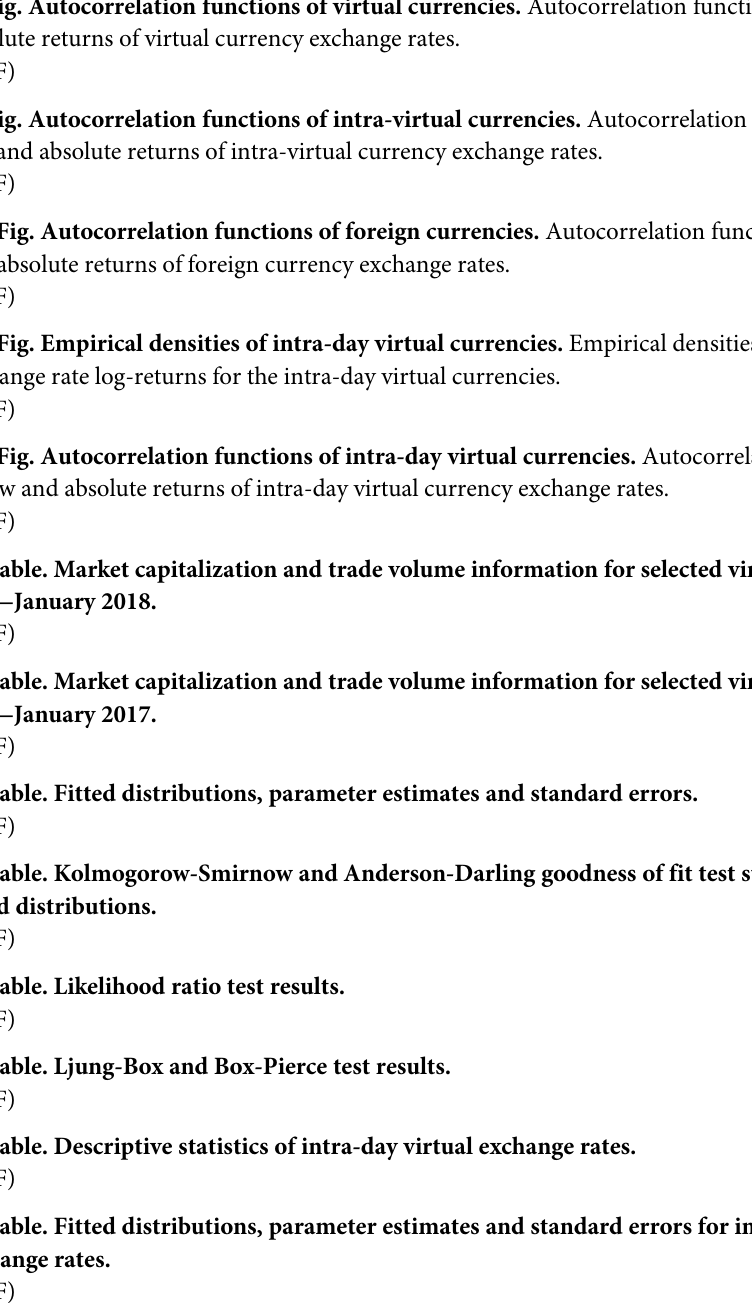
S6 Fig. Volatility clustering in foreign currency log-returns. Volatility clustering in log- returns of foreign currency exchange rate group. (PDF) S7 Fig. Shape parameter κ of Subbotin distribution. Shape parameter κ of Subbotin distribu- tion for virtual, intra-virtual and foreign currency exchange rate log-returns (daily). (PDF) S8 Fig. Autocorrelation functions of virtual currencies. Autocorrelation function of raw and absolute returns of virtual currency exchange rates. (PDF) S9 Fig. Autocorrelation functions of intra-virtual currencies. Autocorrelation function of raw and absolute returns of intra-virtual currency exchange rates. (PDF) S10 Fig. Autocorrelation functions of foreign currencies. Autocorrelation function of raw and absolute returns of foreign currency exchange rates. (PDF) S11 Fig. Empirical densities of intra-day virtual currencies. Empirical densities of currency exchange rate log-returns for the intra-day virtual currencies. (PDF) S12 Fig. Autocorrelation functions of intra-day virtual currencies. Autocorrelation function of raw and absolute returns of intra-day virtual currency exchange rates. (PDF) S1 Table. Market capitalization and trade volume information for selected virtual curren- cies—January 2018. (PDF) S2 Table. Market capitalization and trade volume information for selected virtual curren- cies—January 2017. S3 Table. Fitted distributions, parameter estimates and standard errors. (PDF) S4 Table. Kolmogorow-Smirnow and Anderson-Darling goodness of fit test statistics for fitted distributions. S5 Table. Likelihood ratio test results. S6 Table. Ljung-Box and Box-Pierce test results. S7 Table. Descriptive statistics of intra-day virtual exchange rates. (PDF) S8 Table. Fitted distributions, parameter estimates and standard errors for intra-day exchange